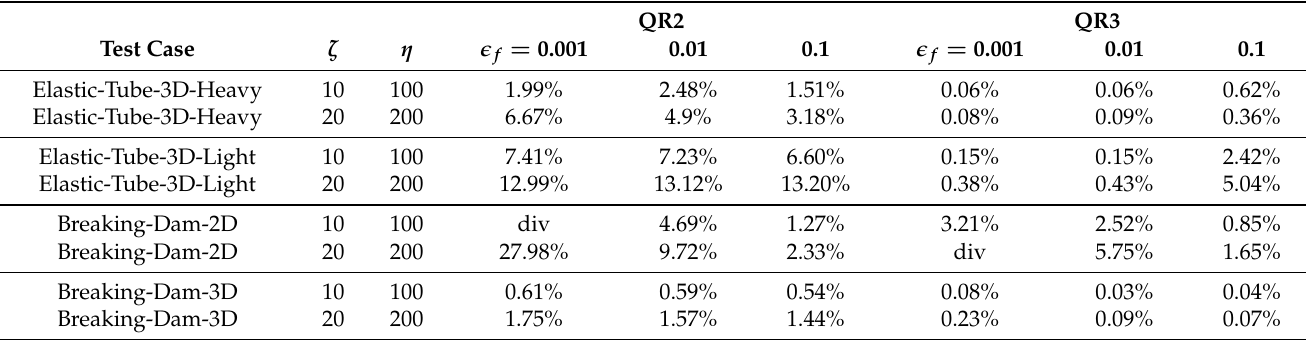
Table 5. QR decomposition and filtering time as a percentage of the total simulation runtime for (i) pre-scaling update in every quasi-Newton iteration with the QR2 filter (QR2), and (ii) the new pre-scaling weight monitoring approach with the new QR3 filter (QR3). Three filter limits (cid:101) f = 0.001, (cid:101) f = 0.01 and (cid:101) f = 0.1 were tested. The test cases used a maximum of η = 100 iterations from previous ζ = 10 time steps, and η = 200 and ζ = 20. QR2